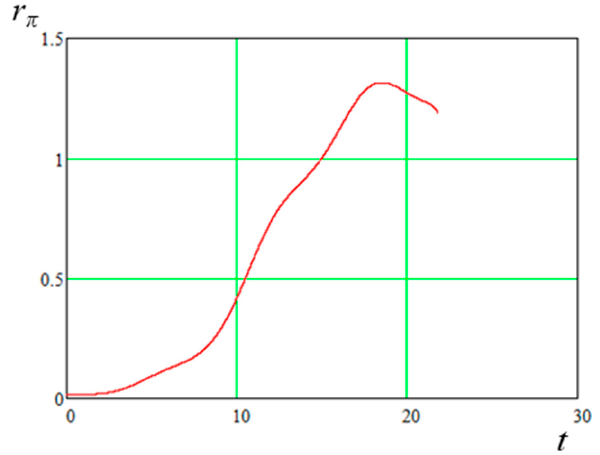
Figure 6. Dependence of the perigee radius [undim.] of the osculating SC orbit as a function of flight time [undim.].